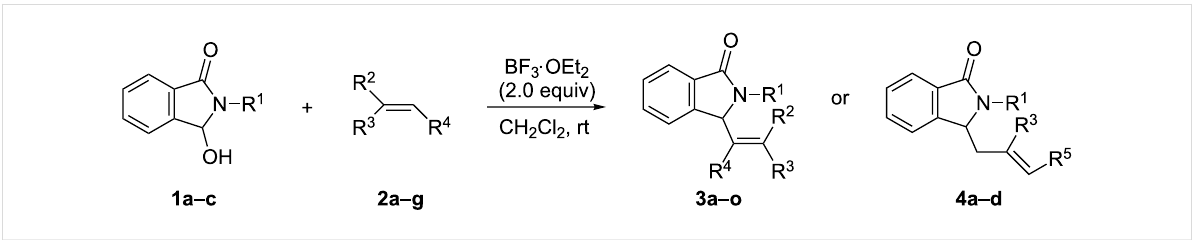
Scheme 3: Reactions of 5-hydroxyisoindol-1-ones with olefins in the presence of BF 3 ·OEt 2 .